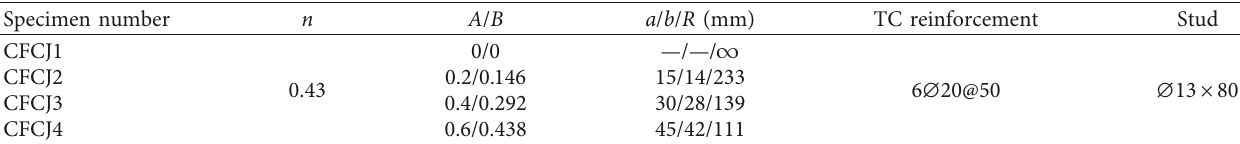
Figure 1: 3D schematic diagram of the Table 1: Geometric details of specimens.